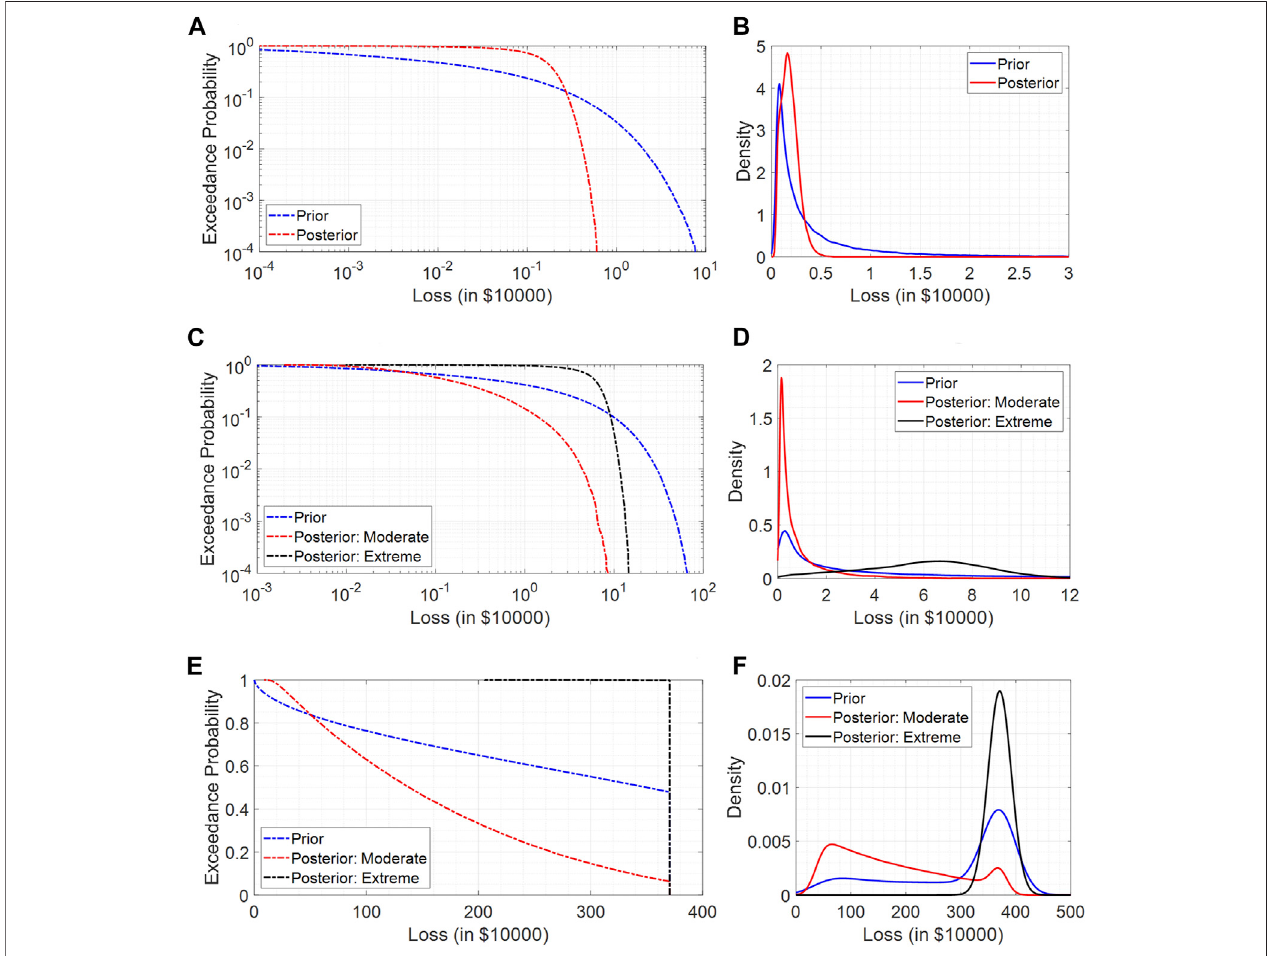
FIGURE 7 | (A) The variation of the prior and the posterior exceedance probability corresponding to the loss for the year 2030 (B) the prior and the updated conditionalposterior distributionoflossgiven probability offailureismore than0.1%for theyear2030, (C) variationofthepriorand theposterior exceedanceprobability corresponding to the loss under the observation of two different climate scenarios (moderate and extreme), for the year 2050, (D) the prior and the updated conditional posterior distribution of loss given probability of failure is more than 0.1% under the observation of two different climate scenarios (moderate and extreme), for the year 2050, (E) the variation of the prior and the posterior exceedance probability corresponding to the loss under the observation of two different climate scenarios (moderate and extreme), for the year 2100, (F) the prior and the updated conditional posterior distribution of loss given probability of failure is more than 10% under the observation of two different climate scenarios (moderate and extreme), for the year